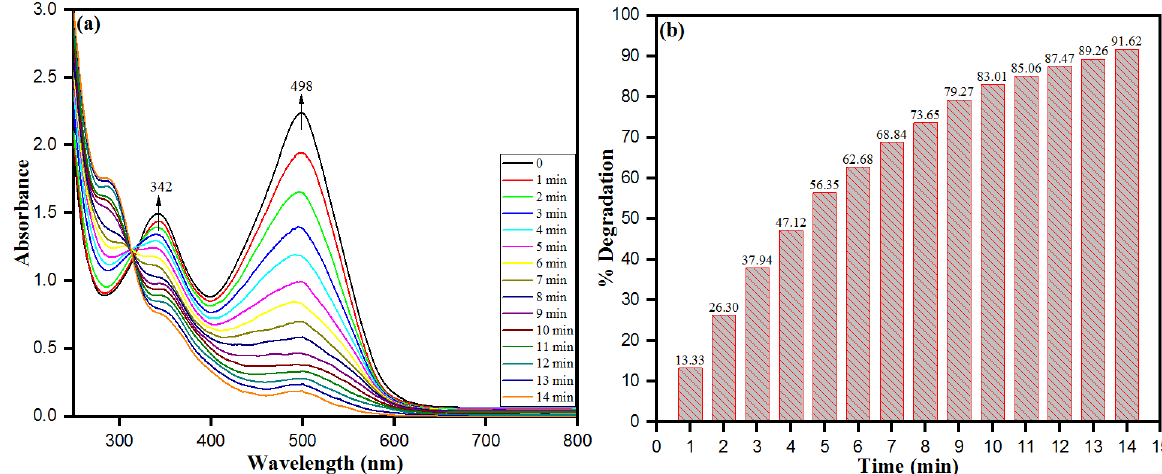
Figure 9. ( a ) UV–visible spectra of CR degradation under optimum experimental conditions; ( b ) percentage degradation of CR dye with respect to irradiation time. (Experimental conditions: (CR) = 0.5 × 10 −4 M, (NaBH 4 ) = 1.0 × 10 −3 M, PdNPs = 4 mg, Temperature = 30 °C).